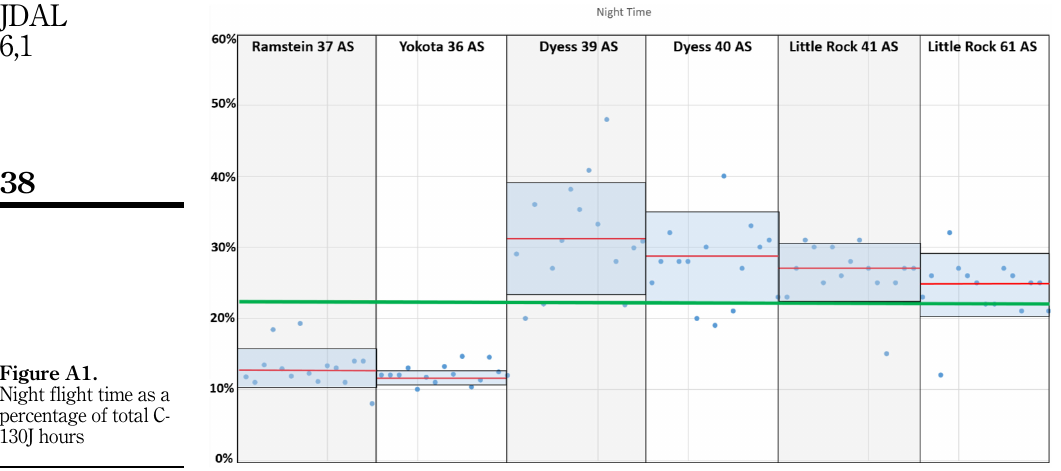
Figure A1. Night flight time as a percentage of total C- 130J